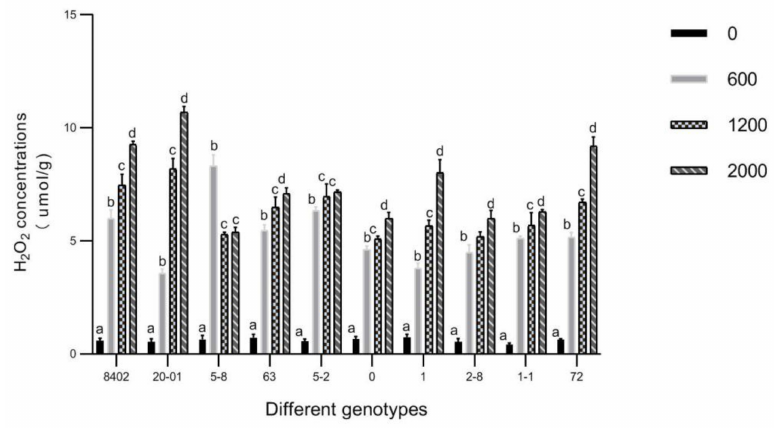
Figure 13. H 2 O 2 concentrations in leaves of C. bungei .